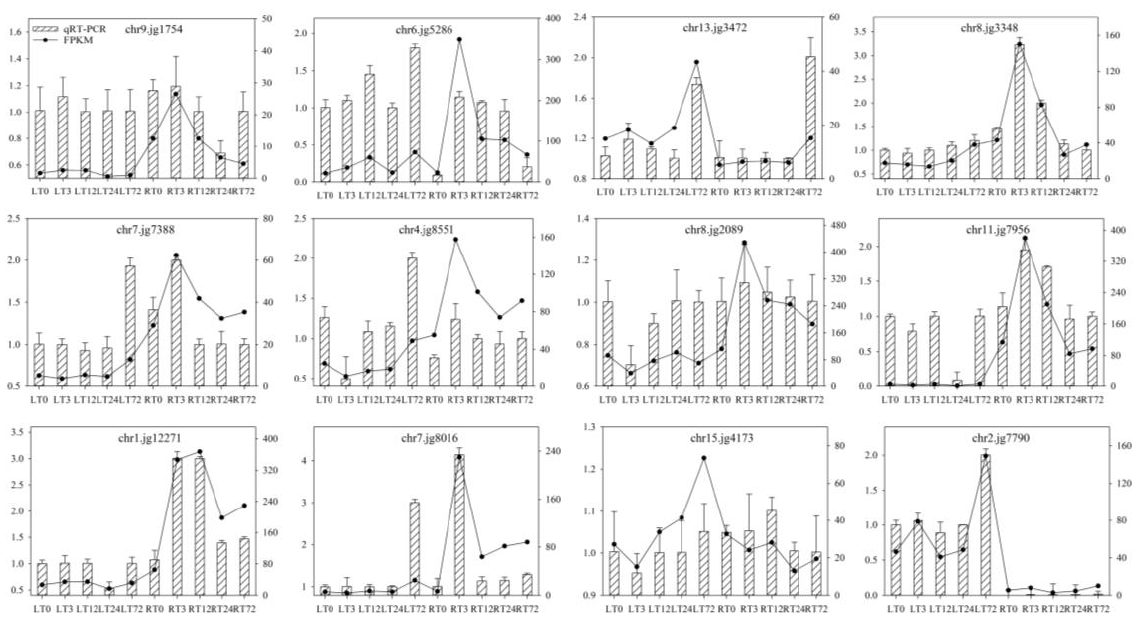
Figure 10. Expression of the selected 12 genes inferred at 0, 3, 12, 24, and 72 h by RNA-seq and qRT- PCR.